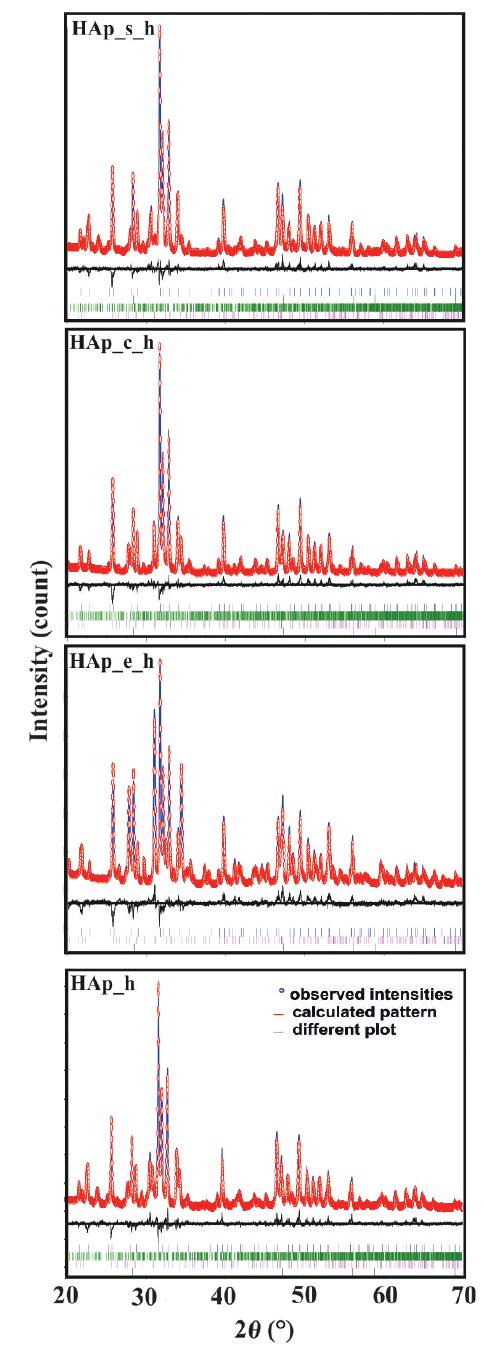
Fig. 4 – Rietveld analysis pattern of powder diffraction data for heat-treated CaP powders obtained from different biogenic sources. The open circles are experimental data and the solid lines are calculated intensities. The difference between the ex- perimental and calculated intensities is plotted below the pro- file (R < 11 %; R < 3 %). Bragg positions of hydroxyapa- wp exp tite, β-tricalcium phosphate, α-tricalcium phosphate and silicon (standard) are marked below each